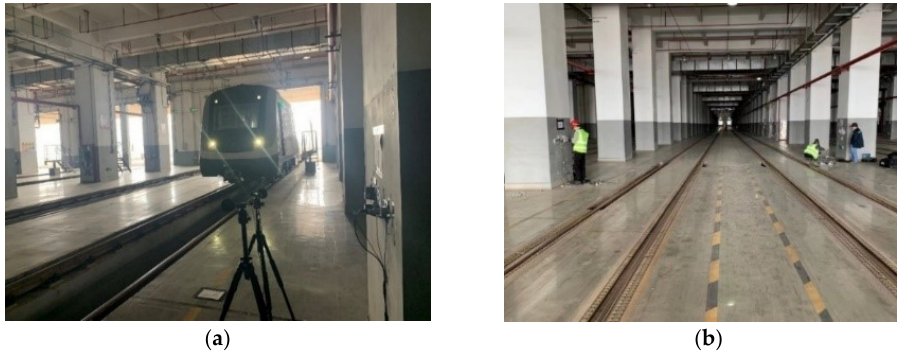
Figure 5. Field testing in the operating metro depot. ( a ) Test train; ( b ) Test tracks.